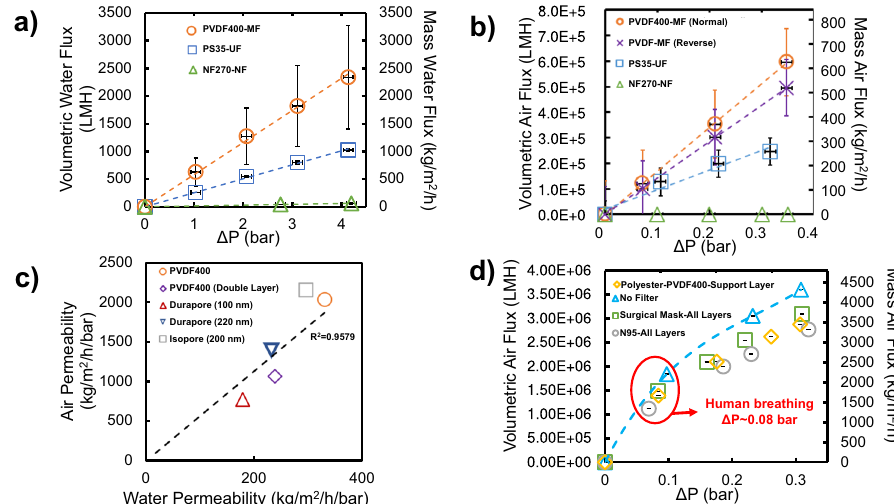
Fig. 3 Characterizing fl ux through various types of membranes and air fi lter material. a Water and b dry-air (0% RH) fl ux results for PVDF400-MF (orange circle and dashed line for normal orientation, purple cross mark and dashed line for reverse), PS35-UF (blue square and dashed line), and NF270- NF (green triangle and dashed line) membranes as a function of pressure drop ( Δ P) (LMH or liters per m 2 per hour for volumetric, kg per m 2 per hour for mass). c Relationship between water permeability and air permeability for speci fi c single sample MF membranes (orange circle for PVDF400, gray square for isopore-200 nm, dark blue invert pyramid for Durapore-220 nm, purple diamond for PVDF400-Double Layer, red triangle for Durapore-100 nm, and black dashed line for linear trendline). Note Durapore (100 nm) is hydrophilic. d Comparison of mask material (all layers) with PVDF400 polyester backing material (yellow diamond for polyester backing, green square for surgical mask-all layers, and gray circle for N95-all layers). No fi lter fl ow is air fl ow through the fi ltration cell with no fi lter/mask/membrane insert (light blue triangle and dashed line), indicating maximum fl ow through the cell at that applied pressure. Water fl ux results were obtained using a dead-end cell with a membrane are of 13.2 cm 2 . Air fl ux data were collected using in-line fl ow cell with an area of 9.23 cm 2 . Error bars represent standard deviations of triplicate data. Both horizontal axis (left and right) apply for all data displayed. Flow rate measurements normalized at STP. The PVDF400 membrane was tested in two orientations for air- fi ltration: with the surface facing the feed side (Normal) and the surface facing the permeate side (Reverse). Error bars represent the standard deviation of 3 different measurements taken on the (Supplementary Fig. 7a), while, with reverse orientation, particles penetrate and then are captured inside the polyester layer pores (Supplementary Fig. 7b), which offers a fl exible fi ltration material